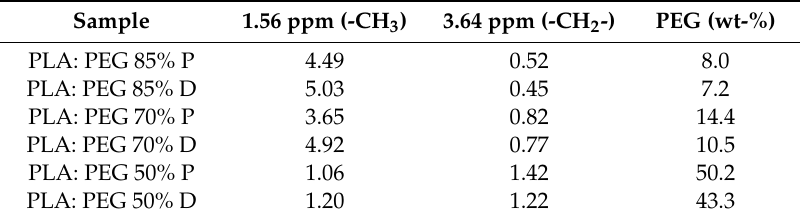
Table 2. Area of characteristic NMR peaks and calculated PEG content of micromolded PLA/PEG specimens with a theoretical PEG content of 15 wt-%, 30 wt-% and 50 wt-%. P and D in the specimen name are indicated the proximal and distal part, respectively.